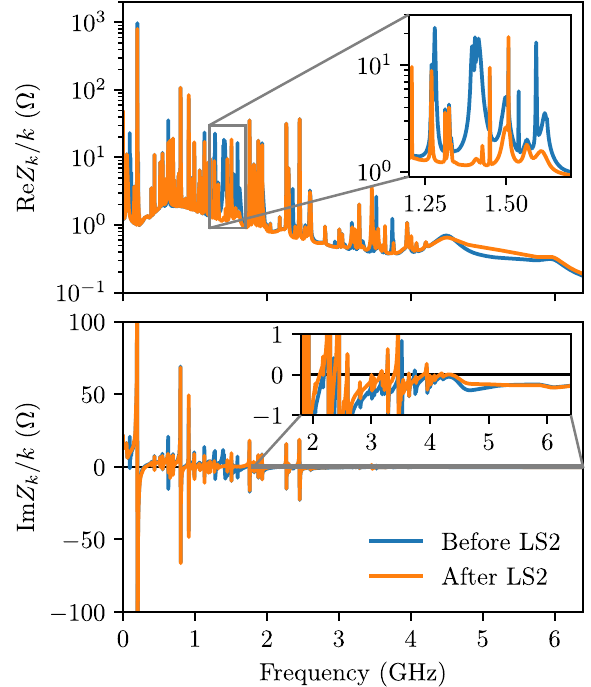
FIG. 1. SPS impedance model separated by real (top) and imaginary (bottom) parts before and after the impedance reduc- tion campaign during the second Long Shutdown (LS2), which ended in March